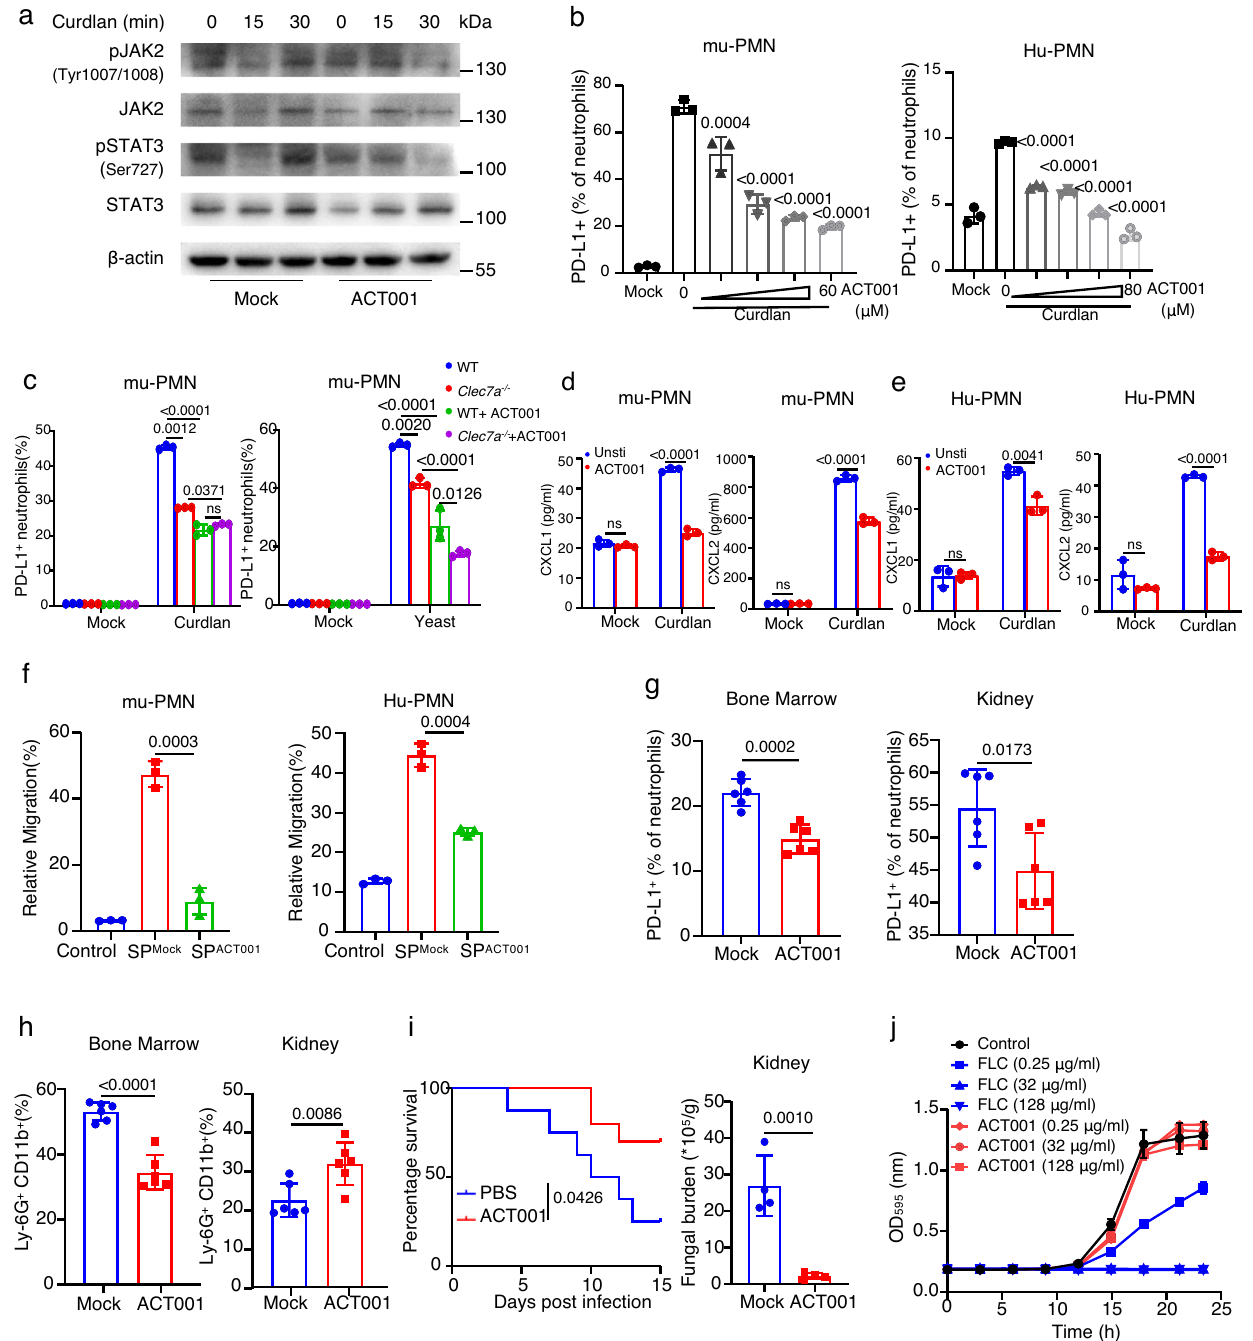
Fig. 7 | ACT001 inhibits PD-L1 expression to enhance neutrophil-mediated antifungalimmunityagainstlethal C.albicans sepsis.a Immunoblottinganalysis of phosphorylation level of JAK2 or STAT3 in mu-PMNs after treatment with ACT001 (40 μ mol/L), which were co-stimulated with curdlan (25 μ g/well) for